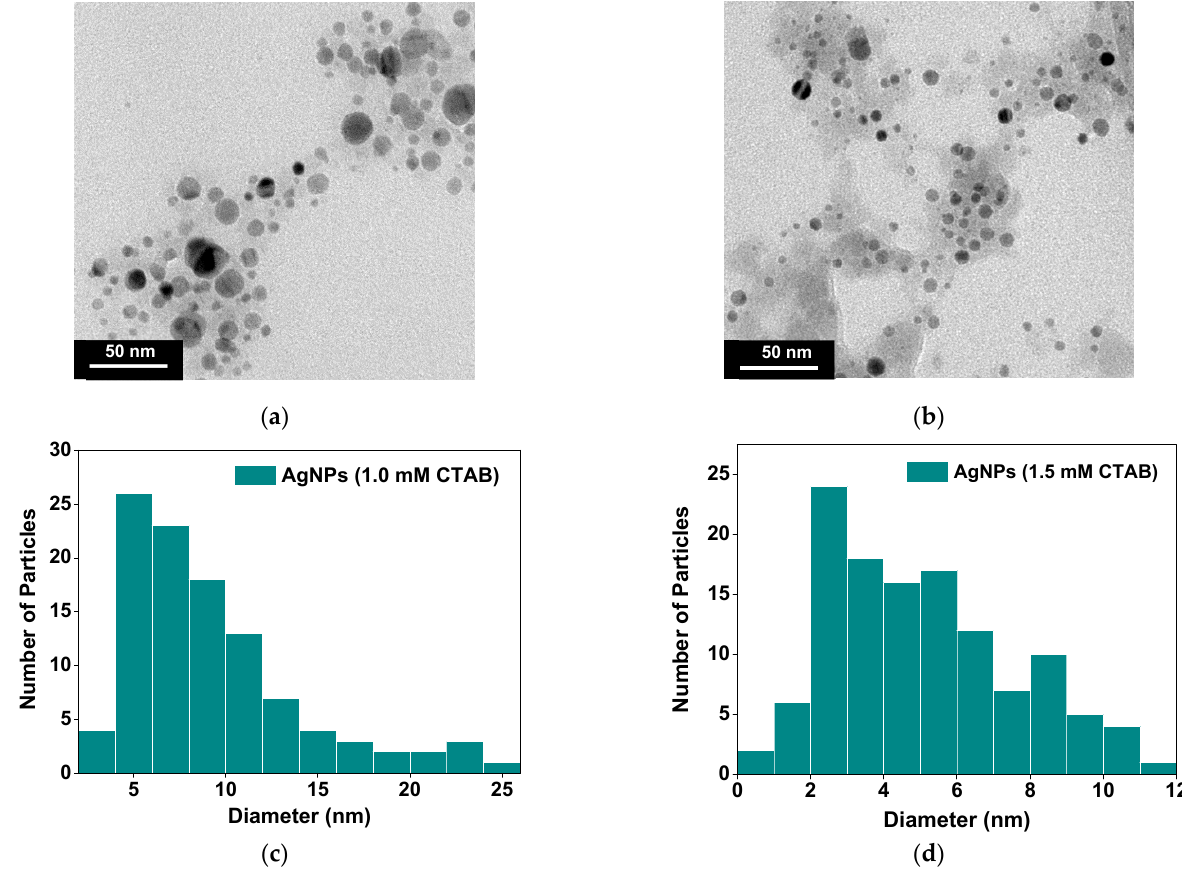
Figure 2. TEM image of ( a ) AgNPs (1.0 mM CTAB) and ( b ) AgNPs (1.5 mM CTAB). ( c ) and ( d ) are their particle size distribution analysis, respectively.